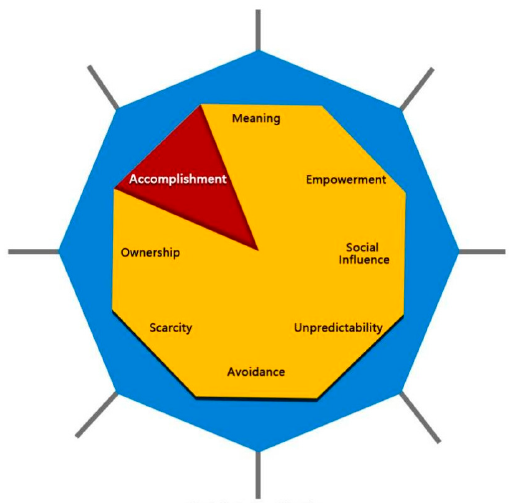
Figure 1. The octagonal behavior analysis graph.